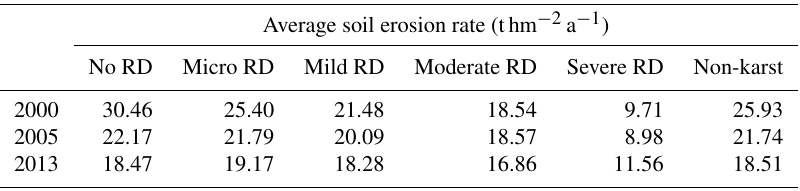
Table 6. Annual erosion rates in different rocky desertification